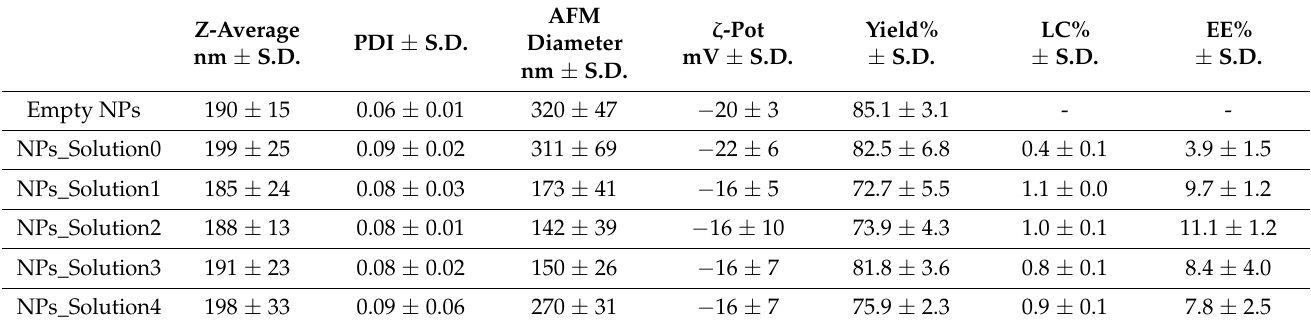
Table 4. Physical characterization and loading content of Tween ® 20: β -Glucosidase solutions in PLGA NPs. AFM Z-Average PDI ± S.D. Diameter nm ± S.D. nm ±